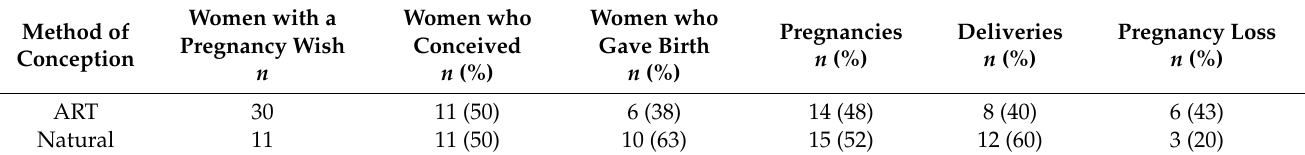
Table 3. Mode of conception and pregnancy outcomes in women after